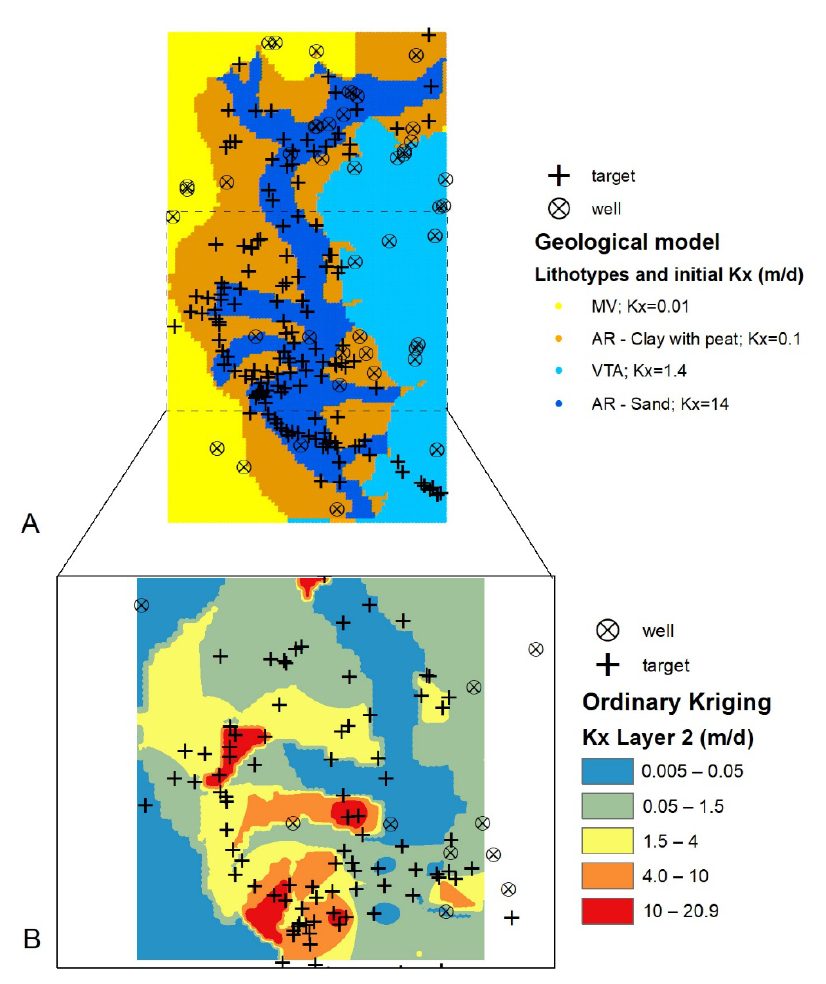
Figure 11. Scatterplot of observed versus computed target values.